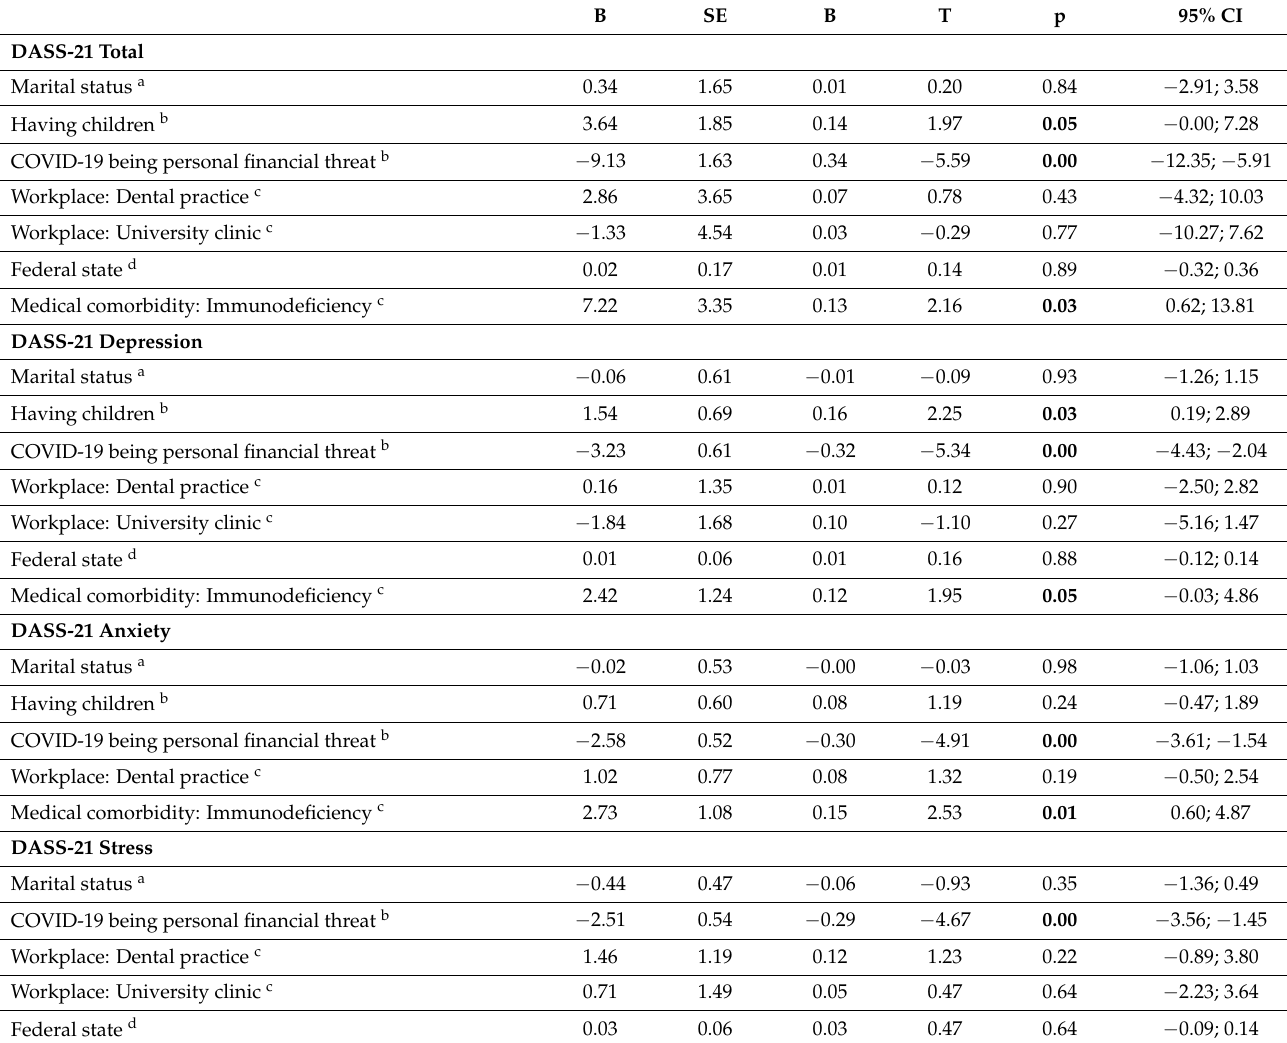
Table 6. Multiple regression studies of DASS-21 total and subscores with pertinent variables.